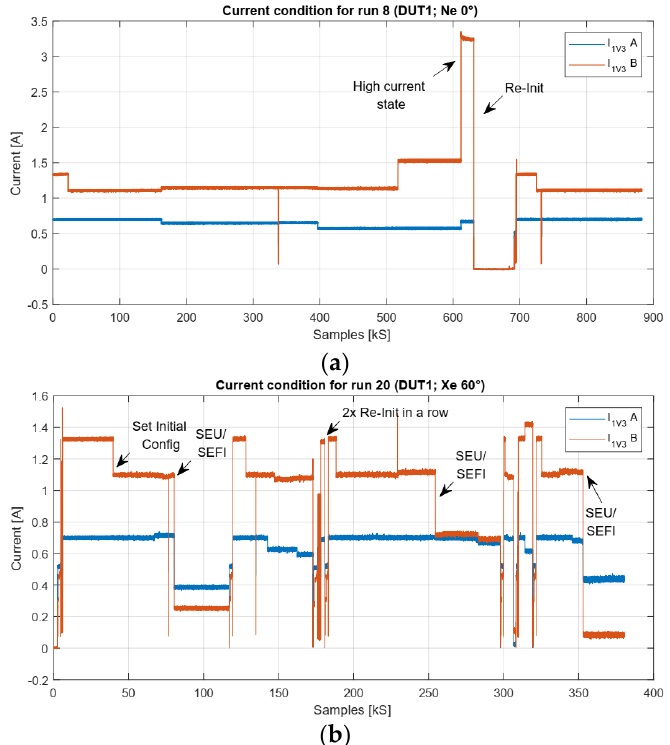
Figure 13. Current conditions during irradiation showing a high current state in ( a ) and several events and their recovery processes in ( b ).